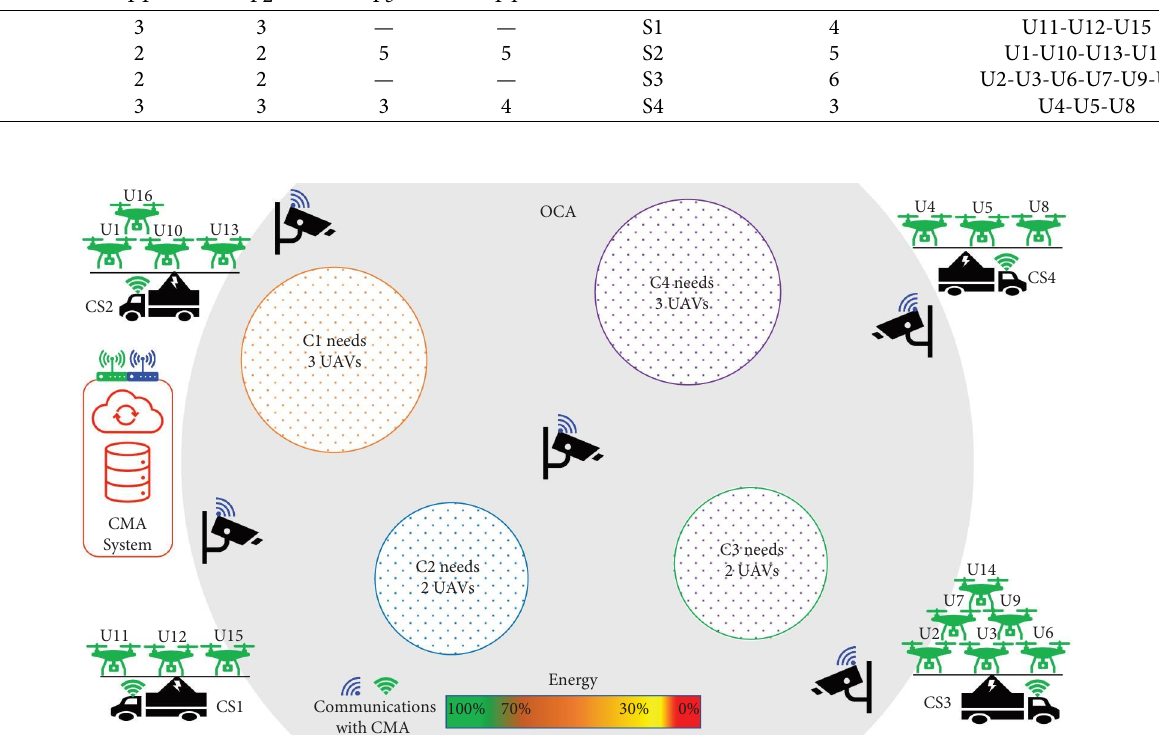
Figure 2: Initial OCA life-cycle state.